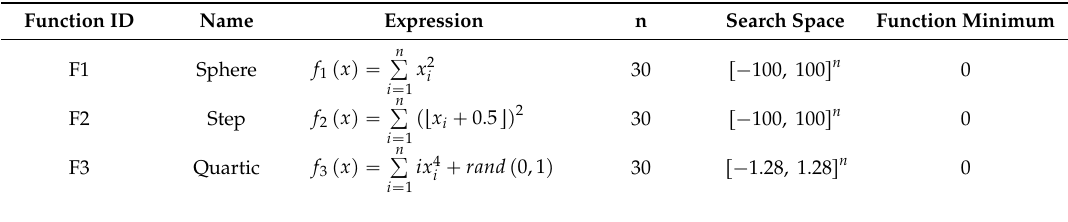
Table 3. Unimodal and separable test